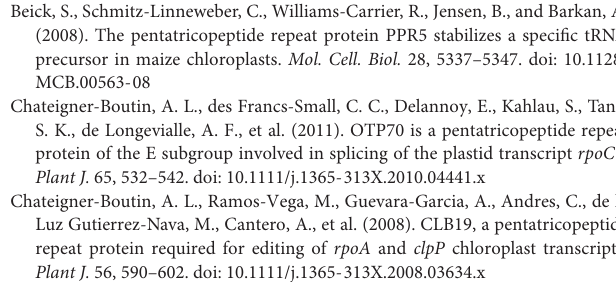
FIGURE S1 | Amino acid sequence alignment of the WSL4 and wsl4 proteins. Premature translation in the wsl4 mutant generated a truncated protein lacking 111 amino acids residues at the C-terminal, compared to WT WSL4 protein. FIGURE S2 | Phylogenetic tree of WSL4 and its homologs in plants. Numbers near the major branches are bootstrap values. GenBank accession numbers for these proteins are: XP_010235566.1 ( Brachypodium distachyon ), BAK03057.1 ( Hordeum vulgare ), XP_004952727.1 ( Setaria italica ), NP_001141010.1 ( Zea